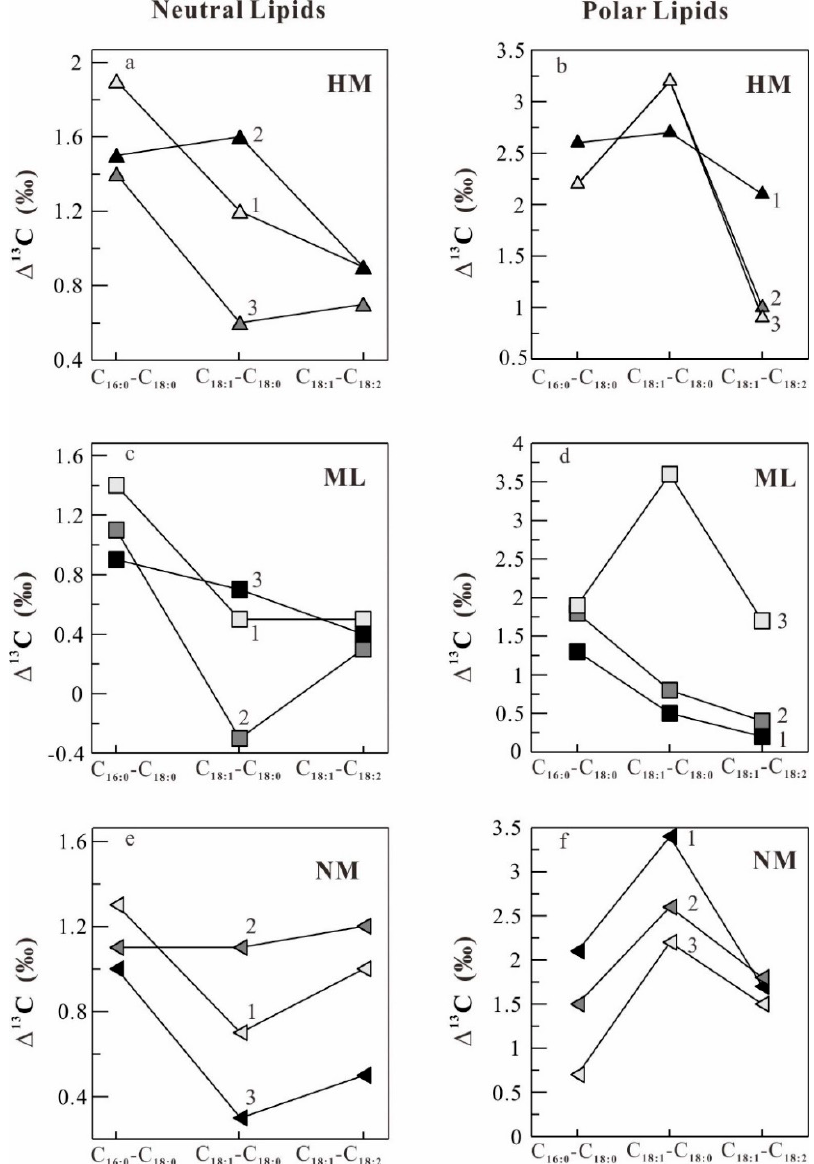
Figure 7. Difference of the δ 13 C values of major fatty acids ( Δ 13 C) among the samples from Heimahe (HM, ( a ) and ( b )), Mila Mountain (ML, ( c ) and ( d )) and Nam Co (NM, ( e ) and ( f )). ( a , c , e ) and ( b , d , f ) refer to neutral and polar lipids, respectively.